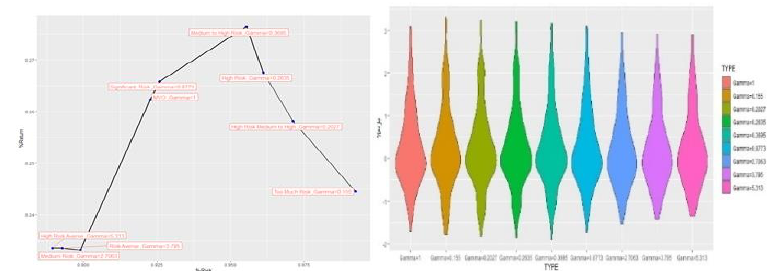
Figure 8. Efficient boundary and Violet diagram for test data and position of selected portfolios (research findings)